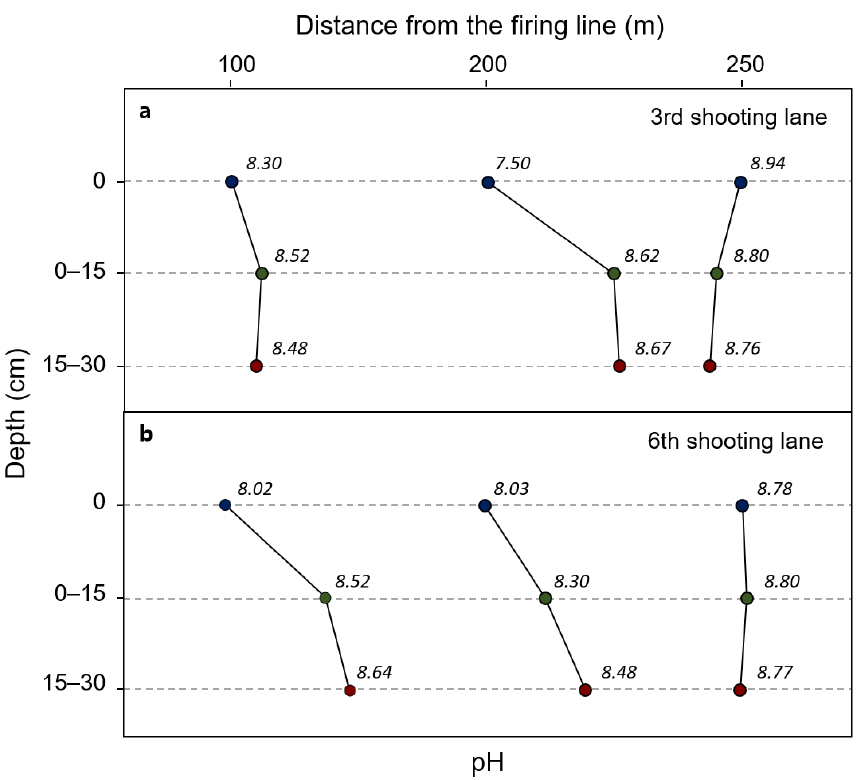
Figure 5. Depth profile of the pH of soils from the ( a ) third and ( b ) sixth shooting lanes of the shooting range.